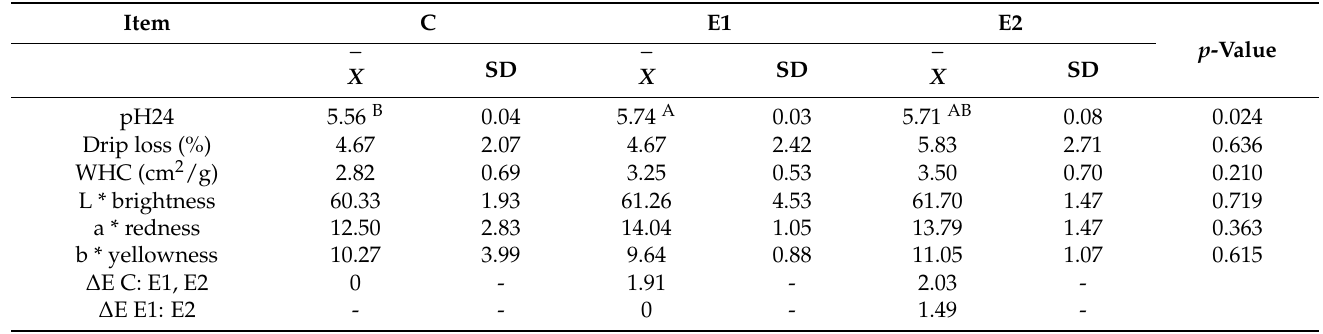
Table 4. Physicochemical properties and color of broiler breasts ( n = 18).